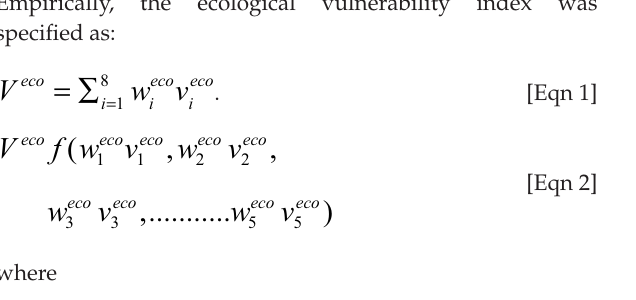
measurement As grazing pressure affected grass cover increase the land is more vulnerable